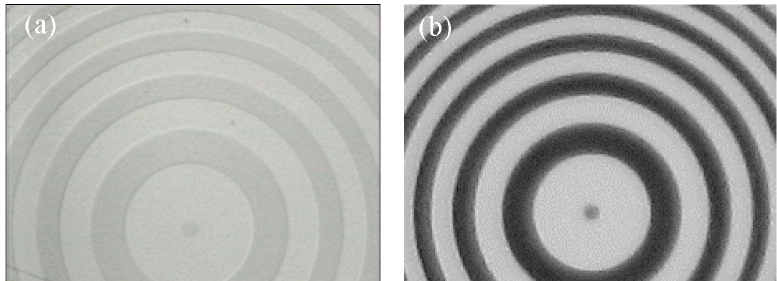
Figure 8. Images of a Fresnel lens written on a photochromic PU film ( T-Ph ). ( a ) An image collected with the phase-contrast microscope in order to highlight the phase modulation induced by the change of the refractive index; and ( b ) an image collected with a standard microscope where the variation of the transparency is enhanced.